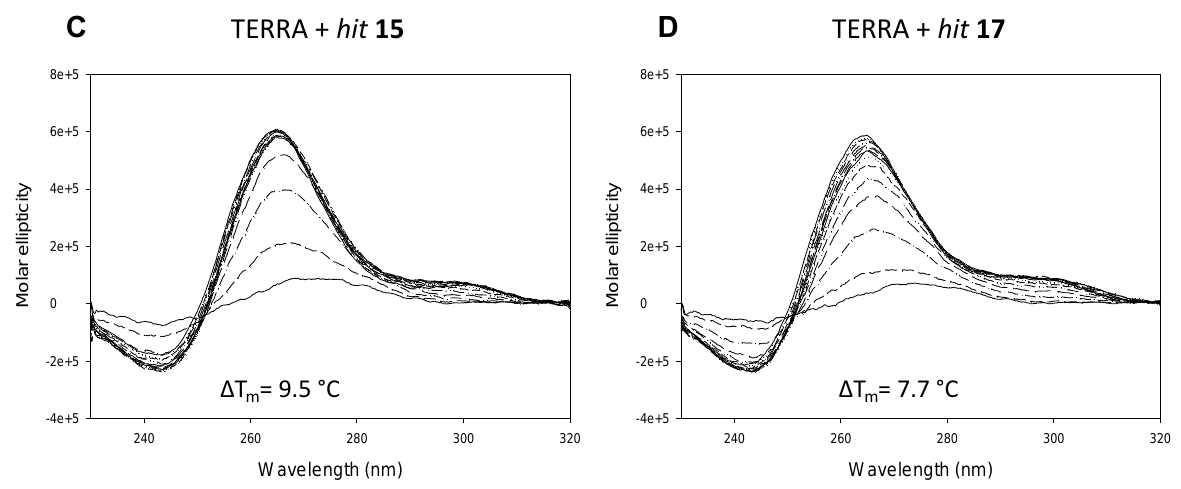
Figure 4. The CD thermal unfolding spectra of the nucleic acid TERRA G4 4 μM in 100 mM K + alone ( A ) and in the presence of hit 7 16 μM ( B ), hit 15 16 μM ( C ), and hit 17 16 μM ( D ). To measure the binding affinity of the hits to the G4-folded oligonucleotides with unmodified 5′ - and 3′ -ends (i.e., lacking fluorophores or biotin), we employed ESI-MS analysis, as previously described [40]. All hits displayed both a 1:1 and 1:2 binding ratio, albeit adducts with 2 bound hit molecules were 2 – 3 times less abundant than those with 1 bound hit molecule. For each hit , the binding affinity (K D ) of the 1:1 complex with Tel and TERRA G4s was measured at three compound concentrations, corresponding to 1:1, 1:2, and 1:4 G4:compound ratios. K D values were 3.4 ± 0.2 μM, 7.1 ± 1.2 μM , and 6.1 ± 0.2 μM for binding of hits 7 , 15, and 17 , respectively, to TERRA G4 (Figures 5 and S11). Binding affinity to Tel G4 was in general lower, with K D values of 11.0 ± 0.7 μM, 18.0 ± 4.2 μM , and 22.9 ± 6.4 μM for binding of hits 7 , 15, and 17 , respectively (Figure S10).